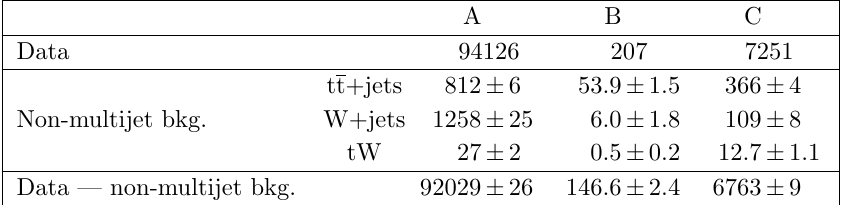
Table 2 . Numbers of events for the control regions A , B , and C in the non-multijet backgrounds, and the di(cid:11)erences between numbers of events in the data and these backgrounds. These di(cid:11)erences are attributed to the multijet background. The uncertainties are statistical